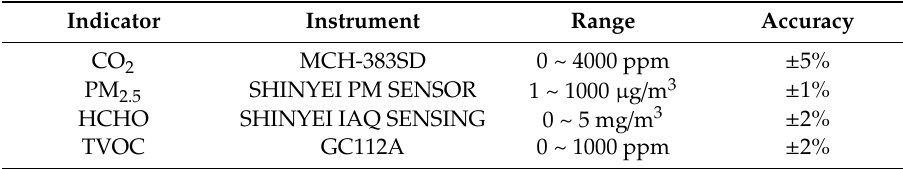
Table 1. Characteristics of instruments for measuring the indoor environment parameters. Indicator